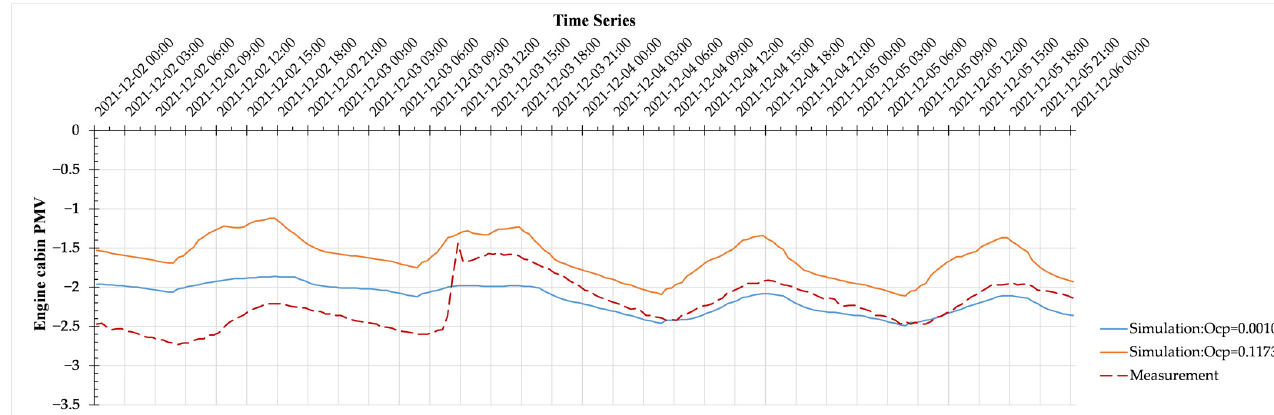
Figure B4. Stern winch cabin: predicted percentage dissatisfied between 2 and 5 December 2021.